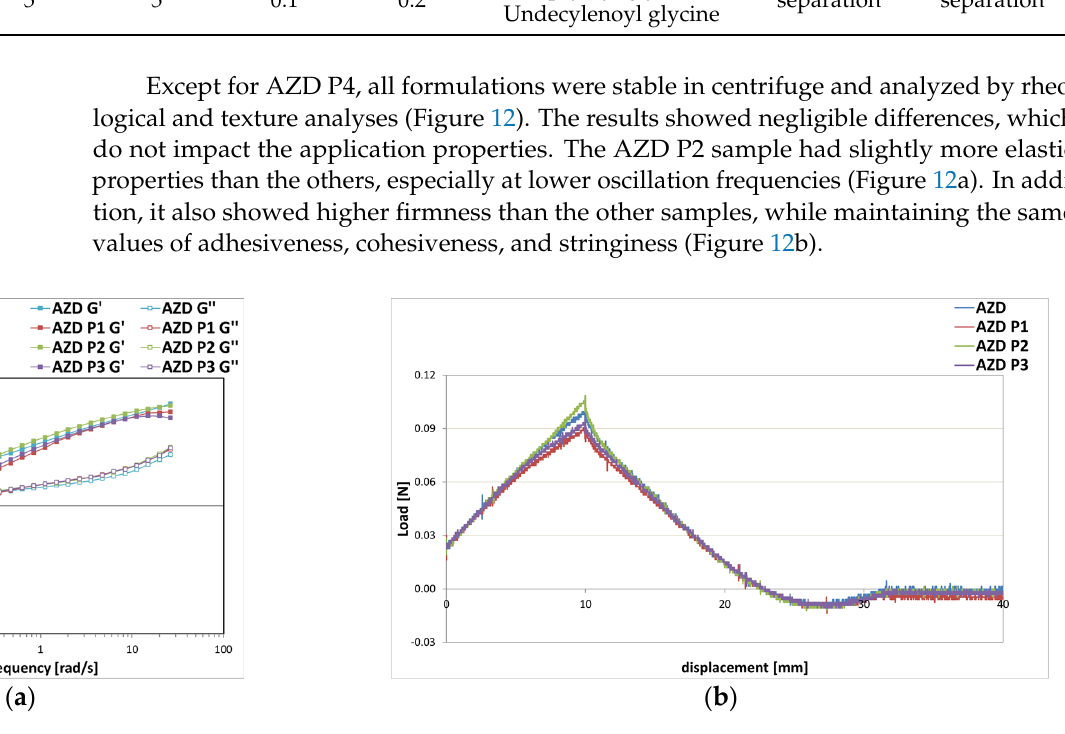
Figure 12. Storage G’ and loss G’’ moduli trend as a function of the oscillation frequency ( a ) and texture curves obtained from an immersion/de-immersion test ( b ) for the emulsions prepared with A-Z associations (ratio 1:1) at a total solid amount of 10% w/w, D at 0.1% w/w, oily phase at 10% w/w and different preservative molecules P1, P2, and P3.